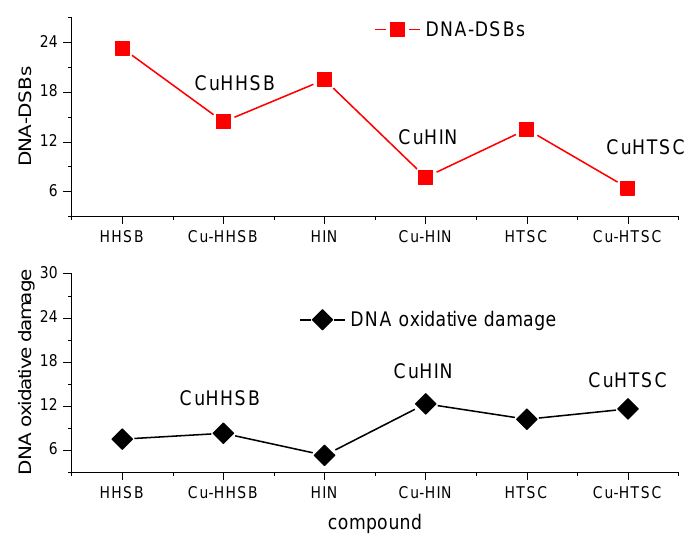
Figure 8. DNA oxidative effect of ligands and copper complexes.